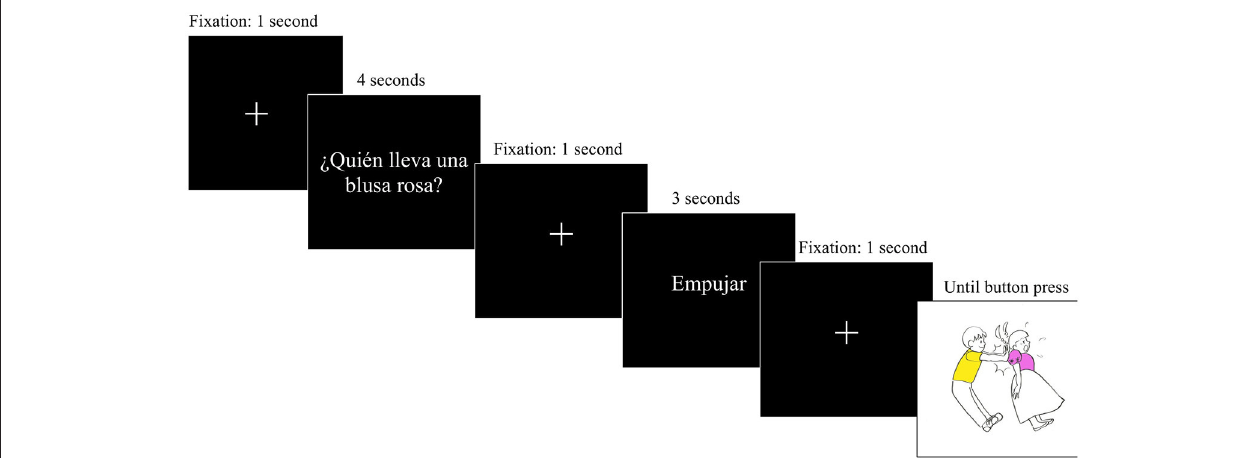
FIGURE 3 | Representation of each trial during the experiment.